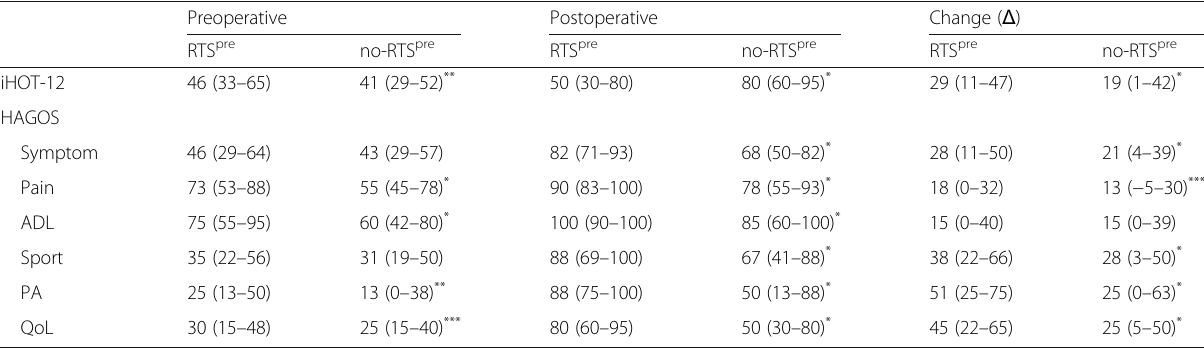
Table 4 iHOT-12 and HAGOS subscales for RTS pre compared with no-RTS pre preoperatively and two years postoperatively